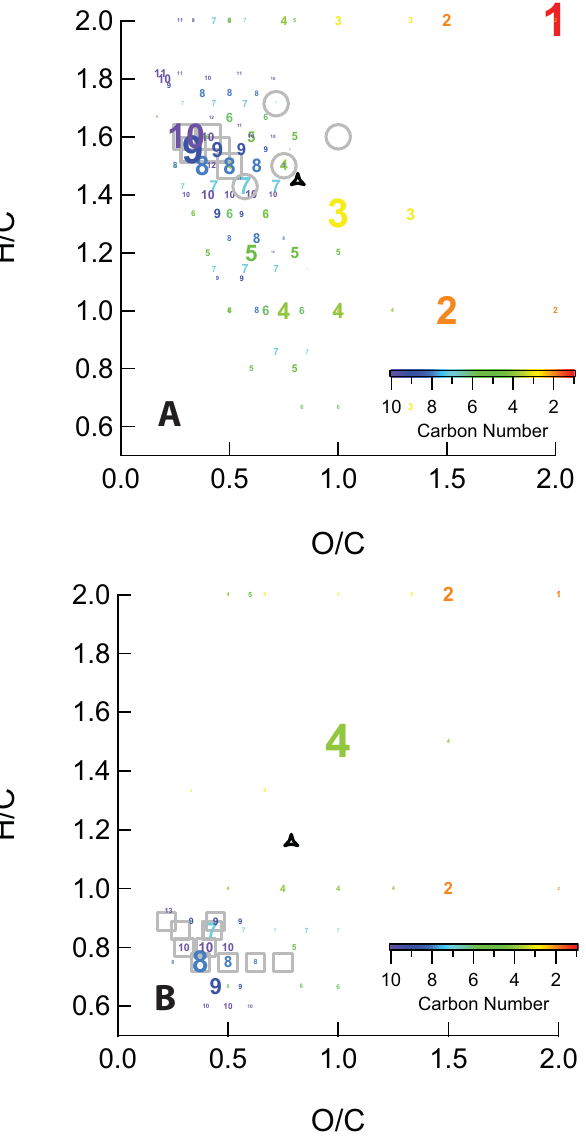
Figure 3. Modified Van Krevelen diagram of gas-phase acetate- CIMS high-resolution spectra of (a) α -pinene ozonolysis (Expt 1) and (b) naphthalene photooxidation (Expt 12). Each integer marker represents a fitted ion with the number representing the carbon num- ber of the ion. The color bar is representative of the carbon num- ber range of the high-resolution spectrum. The size of each num- ber is proportional to the carbon number-weighted signal of its cor- responding ion; the largest markers in (a) and (b) represent 11% and 38% of the carbon-weighted signal, respectively. Gray square markers in (a) indicate tracer acids identified by Yu et al. (1999) and gray circle markers indicate SOA tracer acids noted in Claeys et al. (2013). Gray square markers in (b) indicate tracer acids identified by Kautzman et al. (2009). Names and locations of acids on the VK are shown in the Supplement, Figs. S5 and S6. The bulk O / C and H / C values are marked by black